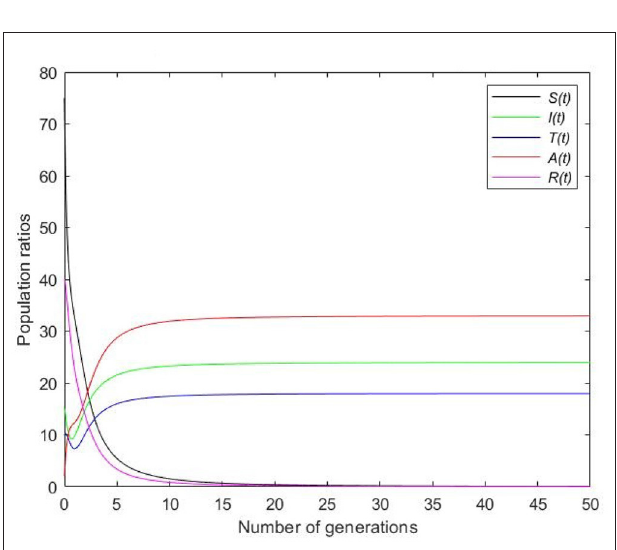
FIGURE 3 | Static simulation for endemic equilibrium.